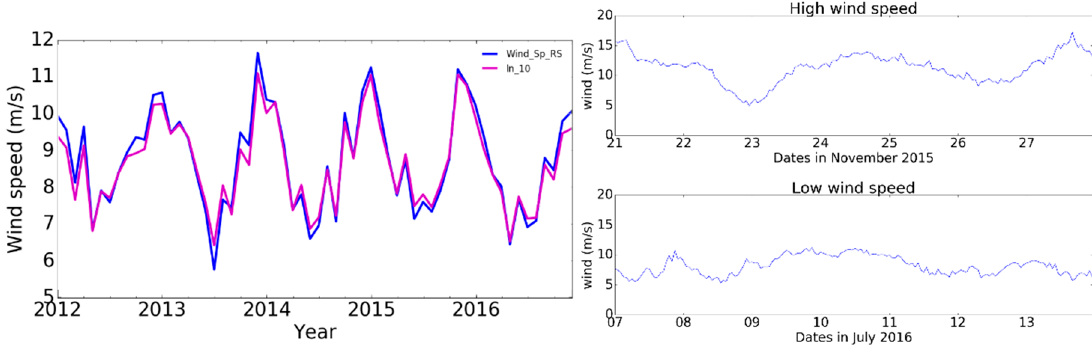
Figure 4. Inter-annual offshore wind variability (m s − 1 ) based on RS ASCAT data and in situ measurements at the M2, M3, M4, M5, and M6 buoys for the years 2012 to 2016 ( left ). Mean hourly wind speed variation for a high wind and low wind speed week derived from the wind speed measured at all buoys ( right ).